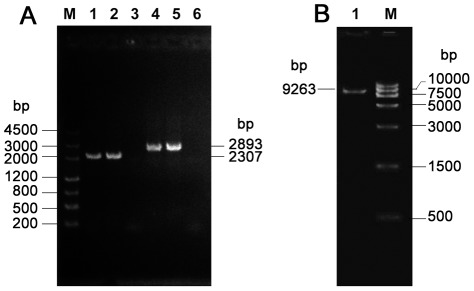
PCR Confirmation of Inversion and vsp Gene Cluster.(A) PCR amplification specific to the upstream and downstream connection sites of the M. bovis HB0801 inversion region. Lanes 1–3 represent PCR products using the primer Inv-1 specific to upstream connection region of the inversion. Lanes 4–6 represent PCR products using primer Inv-2 specific to the downstream connection region of the inversion. Lanes 1 and 4 used the HB0801 genome with pneumonia origin as the template, Lanes 2 and 5 used the HB1007 genome with mastitis origin as the template, and Lanes 3 and 6 represent PCR products using the M. bovis ATCC® 25523™/PG45 genome with mastitis origin as the template. (B) PCR product of the vsp region in the HB0801 genome.